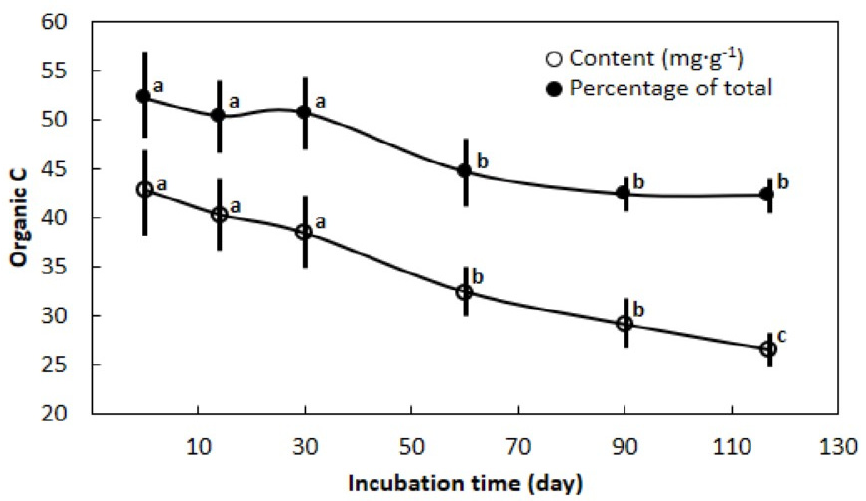
Figure 2. The influence of soil amendment with Cycas micronesica and Morinda citrifolia leaf litter on changes in carbon status over a 117-d incubation period. Means with the same letter are not statistically different according to Tukey’s HSD. Mean ± standard error, n = 18.